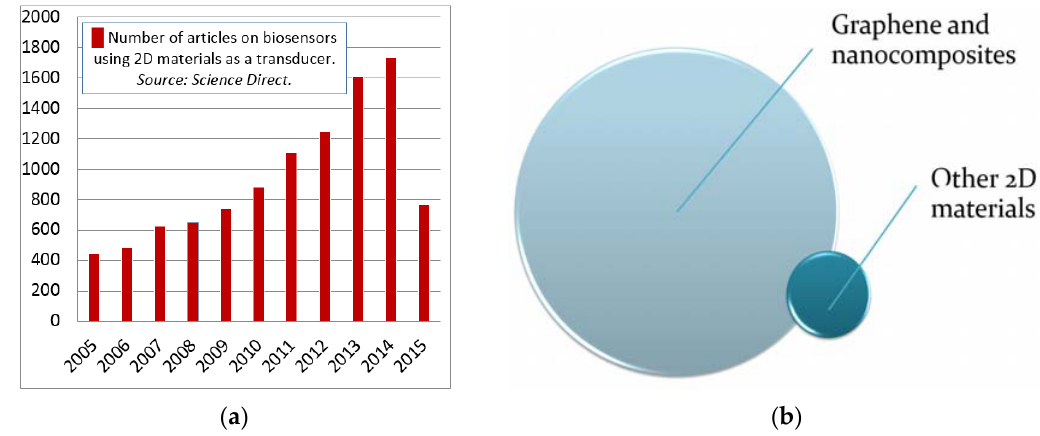
Figure 5. Dynamics of the reports on 2D materials application as a transducer material for biosensors during 2005–2015. Source: Science Direct ( a ). Among them, in 2014–2015: data on the biosensor articles reporting graphene and its nanocomposites as a transducer vs. non-graphene 2D materials ( b